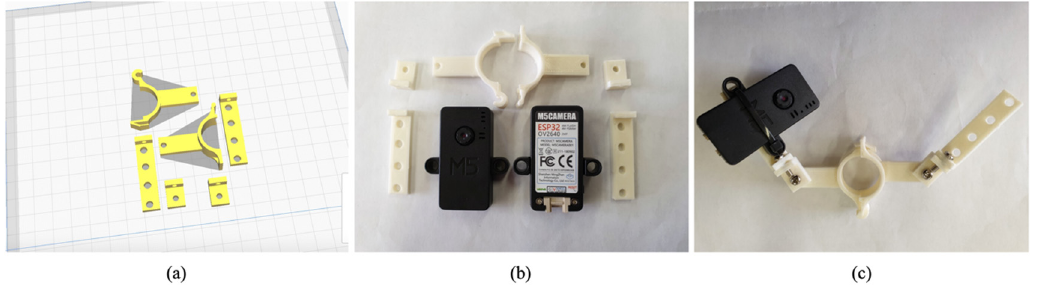
Figure 4. Self-designed clip-type IoT camera. IoT: Internet of Things. ( a ) A 3D model of the clip; ( b ) A printed clip and IoT cameras; ( c ) A clip-type IoT camera.